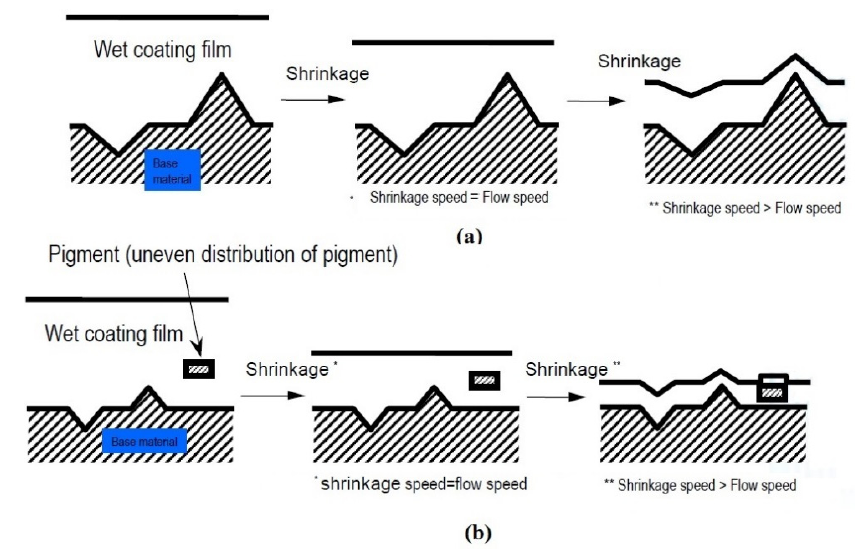
Figure 8. Formation mechanisms of unevenness with ( a ) wavelength 1–5 mm and gloss unevenness with ( b ) wavelength 0.01–0.1mm caused by paint material shrinkage on a base material.